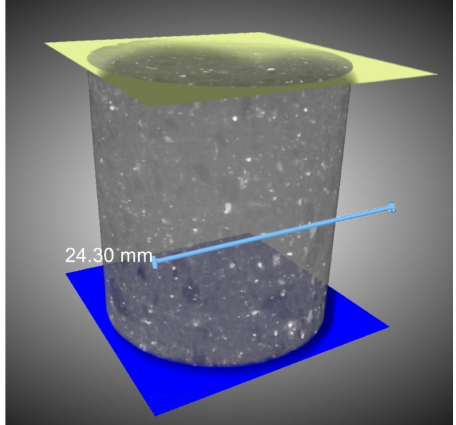
Figure 1. A µ CT dataset of the basaltic andesite sample with the locations of the top and bottom surfaces scanned with µ XRF in the yellow (top) and blue (bottom) planes.